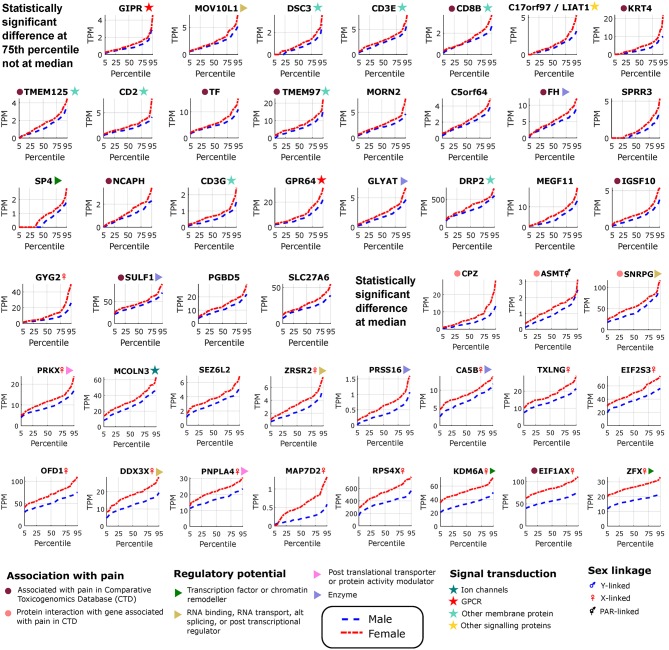
Differentially expressed genes in female tibial nerves. Quantile values for TPMs of sex-differentially expressed genes in BSL that are more abundant in females. Sex linkage, signal transduction and regulatory potential, and association with pain are also shown. Genes are shown in increasing order of the area between the curves.